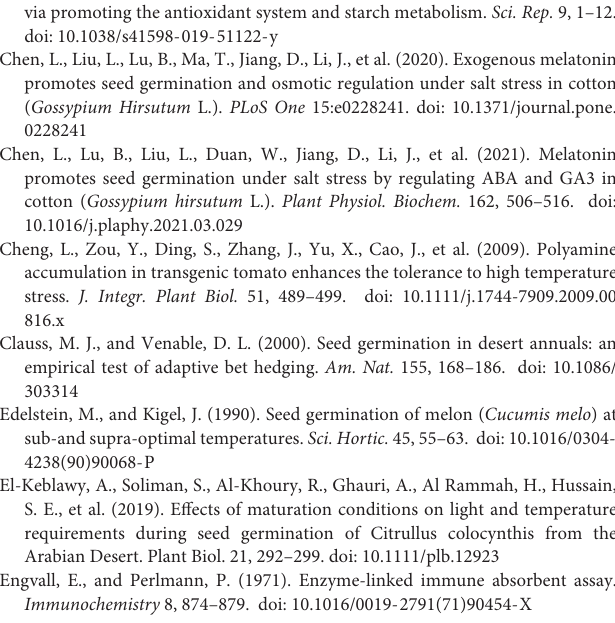
Supplementary Table 5 | Two-way ANOVA test for an antioxidant system under LT.